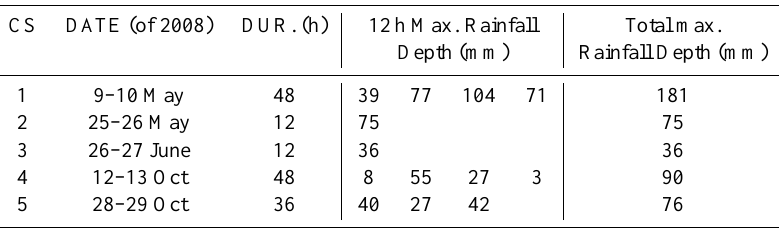
Table 2. Main rainfall features of the five events studied measured with the rain gauge network (XEMA). The rainfall depths are from the rain gauge with the maximum value for the given period of time.